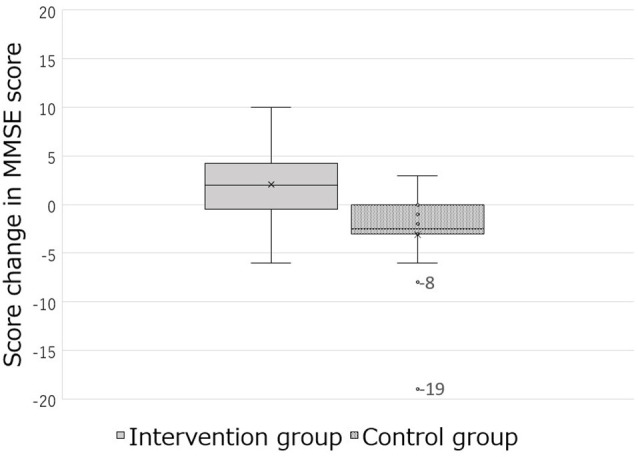
The box-and-whisker plot of the change in MMSE-J score with different interventions.